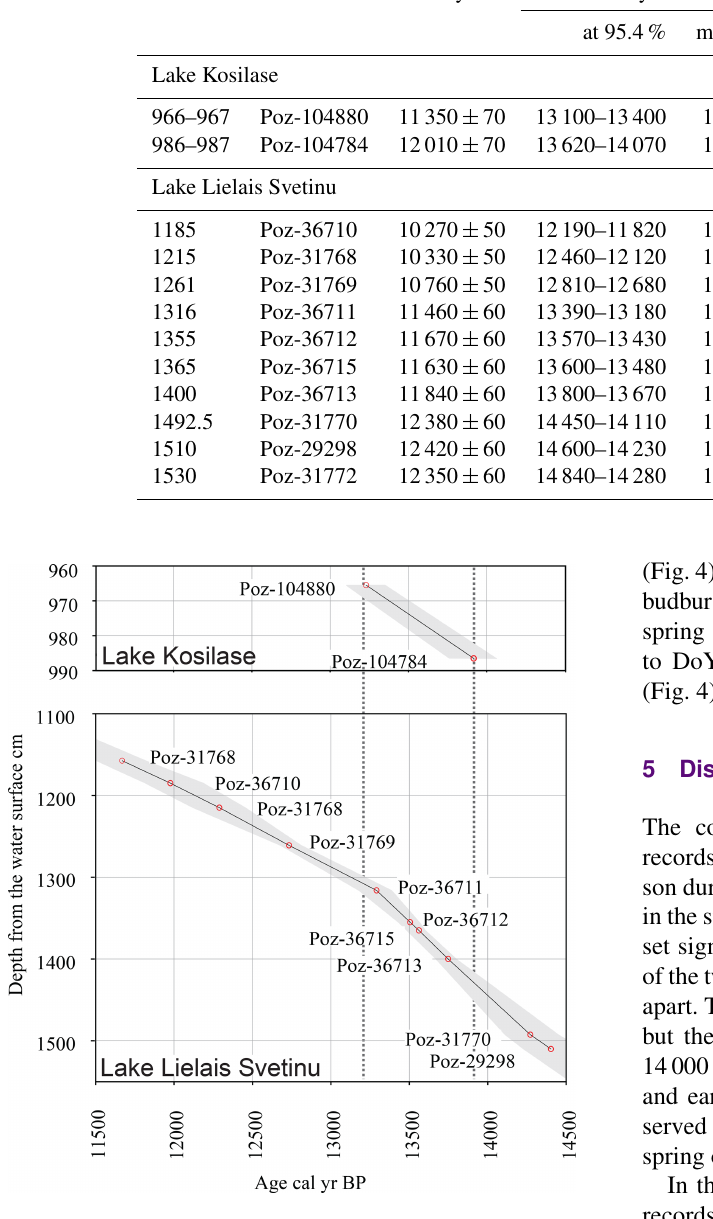
Figure 2. The age–depth models for Lakes Kosilase and Lielais Svetinu. The light grey area marks the possible modelled age range at a 95.4% probability. The black line and red dots are modelled median